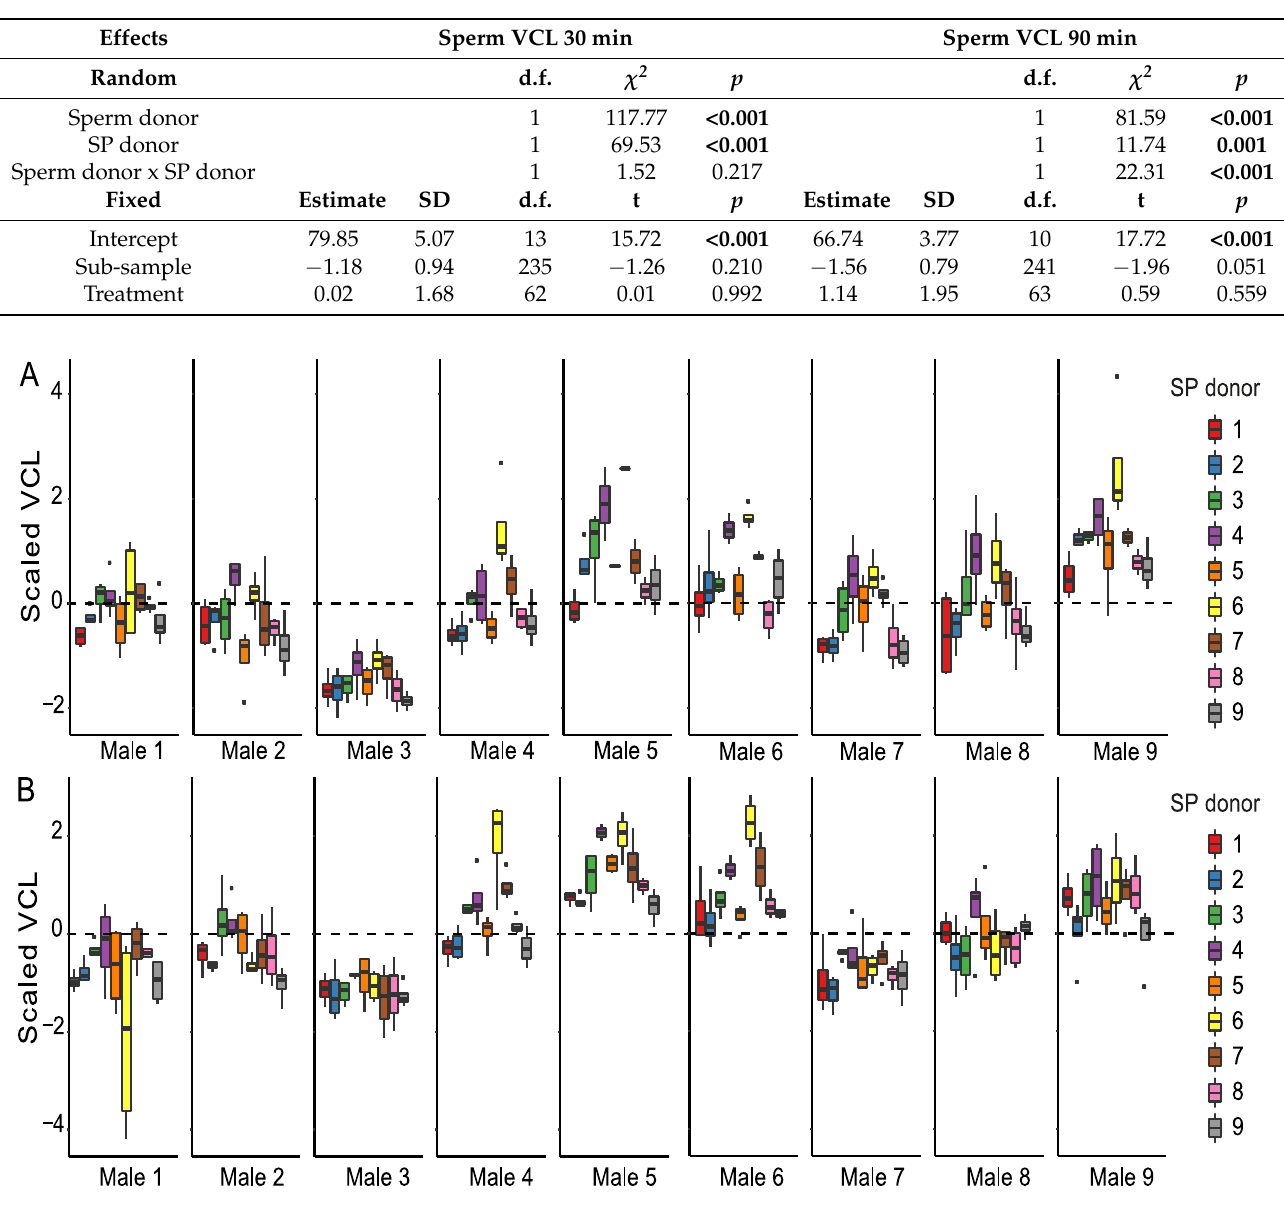
Figure 2. Sperm swimming velocity (VCL) in SP-treated sperm samples. Sperm VCL is scaled to a mean of zero (dashed line, see methods for details) to enable male-to-male comparison at 30 min ( A ) and 90 min ( B ) time points. Each male (1–9) is represented in a separate panel and the SPs used for sperm treatments are indicated by different